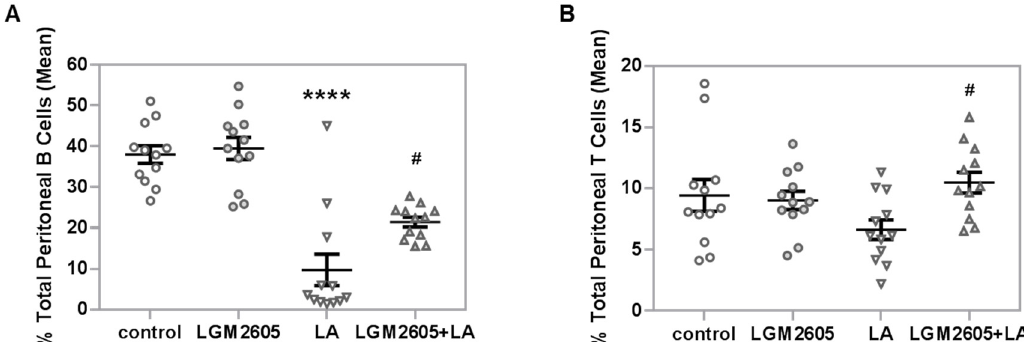
Figure 6. Detection of total peritoneal B and T cells by flow cytometry. ( A ) LA treatment significantly reduced the percentage of total peritoneal B cells compared to saline control, **** p < 0.0001. LGM2605 + LA treatment partially restored the percentage of total peritoneal B cells ( p = 0.017), though they were still significantly lower than saline control or LGM2605 only ( p < 0.001). ( B ) LGM2605 + LA treatment restored the percentage of total peritoneal T cells to control levels, # p = 0.0317. No effect of sex was noted for B or T cells. Following two-way ANOVA, data were analyzed via Tukey post-hoc test.